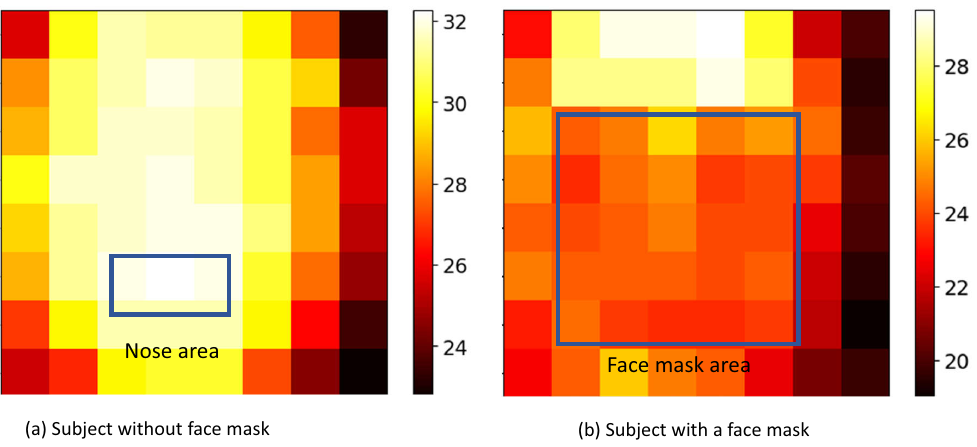
Figure 3. Examples of a subject face (with and without a face mask) captured by thermopile array sensor at the distance of 10cm.